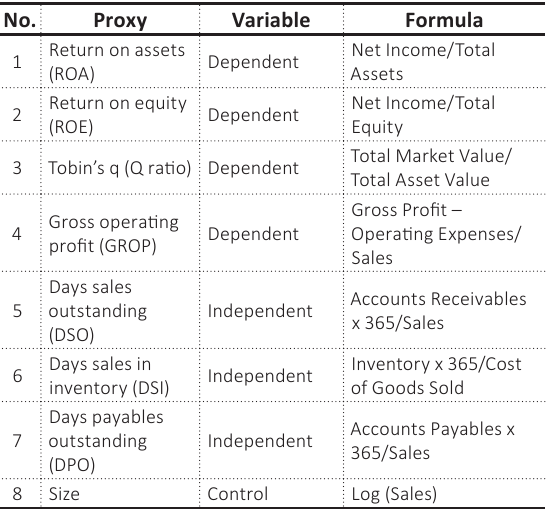
Table 1. Dependent and independent